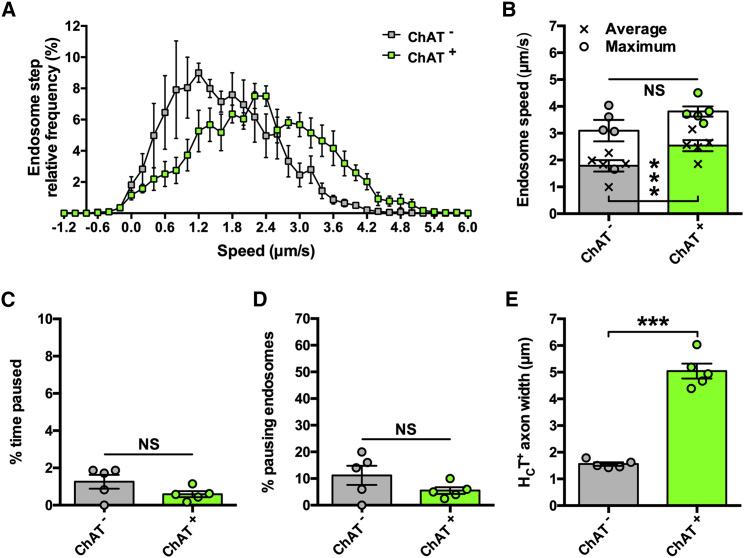
Retrograde Axonal Transport of Signaling Endosomes Is Faster in Motor Neurons Than Sensory Neurons(A) Speed distribution curves of signaling endosome frame-to-frame movements in motor (ChAT+, green) and sensory axons (ChAT−, gray) indicate that axonal transport is faster in motor neurons.(B) Mean (crosses), but not maximum (circles), endosome transport is faster in motor neurons when calculated per animal.(C and D) There is no difference between motor and sensory nerves in the percentage of time endosomes paused for (C) or the percentage of endosomes that paused (D).(E) HCT-containing axons that are ChAT+ have a larger caliber than ChAT− axons.∗∗∗p < 0.001 and NS, not significant, paired t test. n = 5. Means ± standard error of the mean (SEM) plotted for all graphs.See also Figure S1.